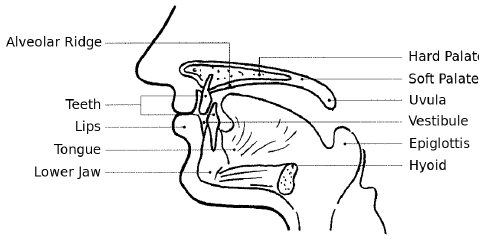
Figure 1. Main places of articulation in the vocal tract, adapted from Reference [5].